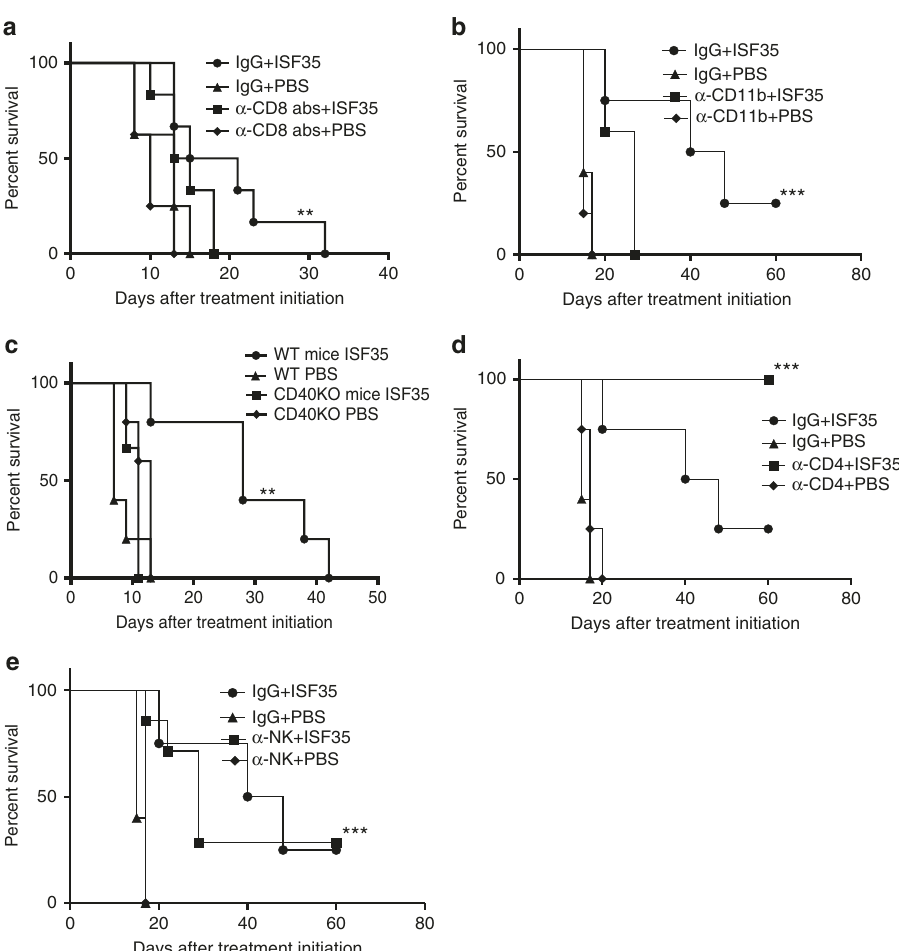
Fig. 3 Mechanism of action of intratumoral ISF35-mediated antitumor activity. Mice bearing 8-day s.c. B16.F10 tumors were treated every 4 days with ISF35 or PBS and depleting antibodies as indicated. The graphs show the survival of a CD8 T cell and b CD11b cell-depleted c CD40 KO mice d CD4 cell and e NK cell depleted and after ISF35 treatment. Survival analysis was performed with the log-rank test ( n = 8). ** P < 0.005, *** P < 0.0005. Error bars are